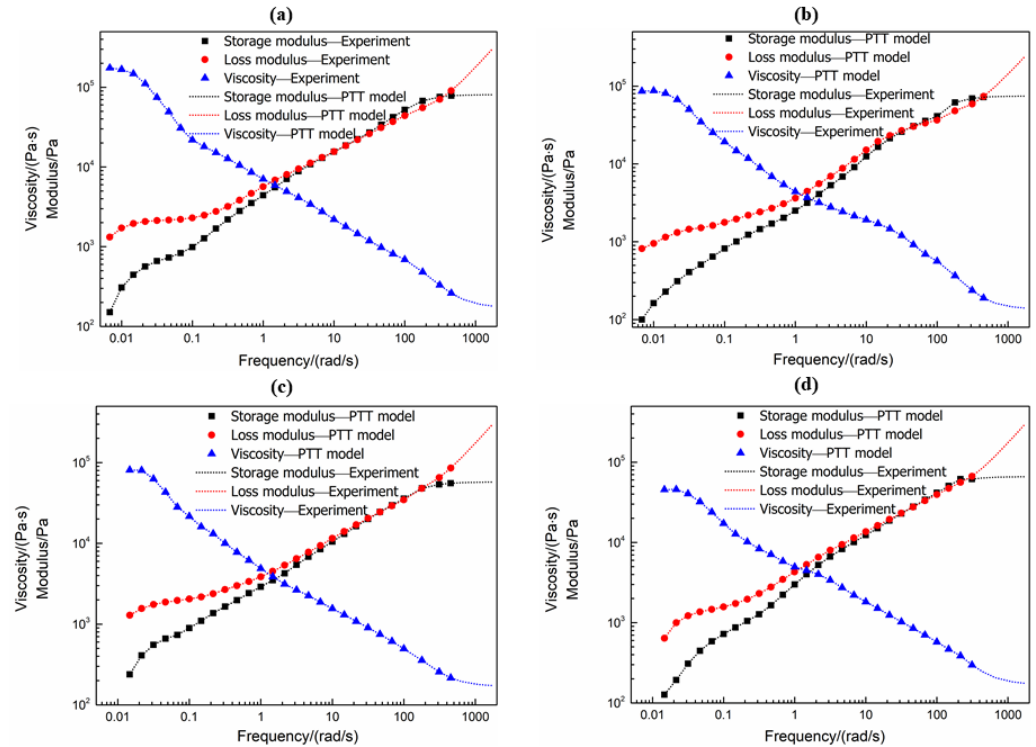
Figure 4. The experimentally recorder linear viscoelastic properties and PTT model fitting curves of PET melt: ( a ) 271 °C; ( b ) 274 °C; ( c ) 277 °C; ( d ) 280 °C.